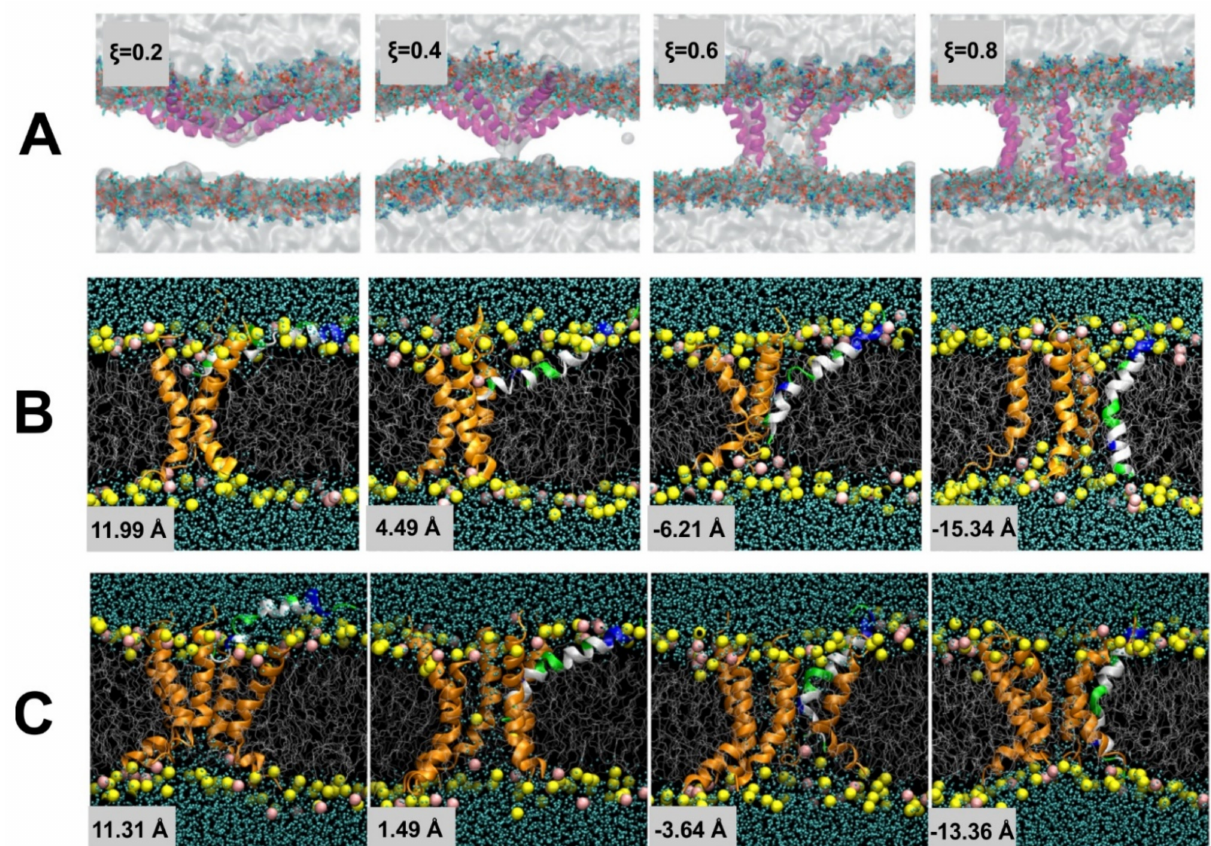
Figure 16. ( A ) Snapshots of stages of pore formation along the collective variable ξ . Reproduced with permission from ref [832]. Snapshot demonstrating the insertion of a single helix into the membrane (colored by residue polarity) where pores formed of ( B ) 3 and ( C ) 5 helices are present. Reproduced with permission from ref